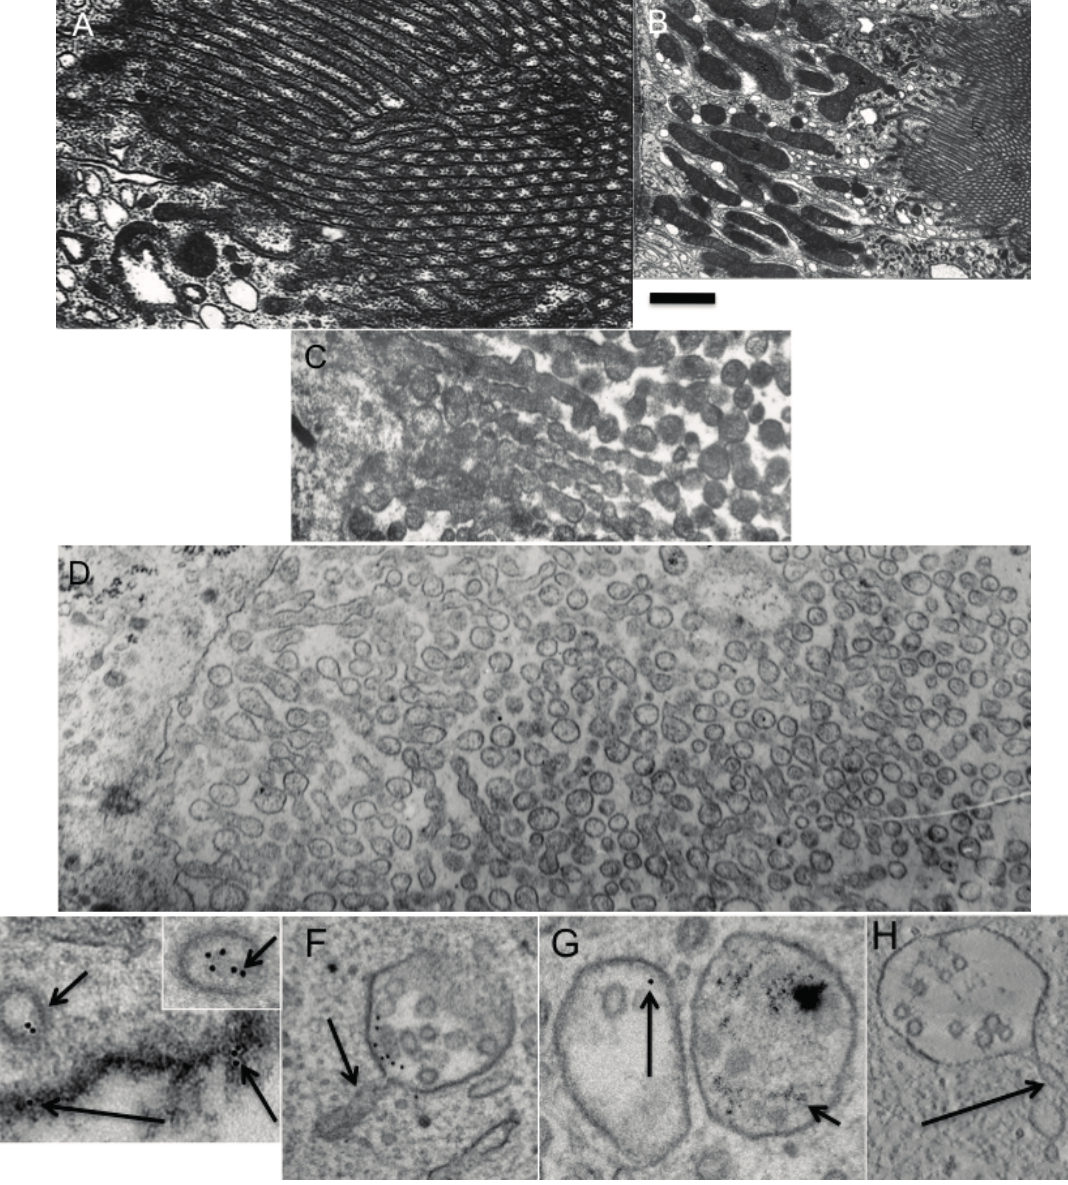
Figure 7. Breakdown of epithelial microvilli of kidney proximal tubule into membrane spheres. ( A ). Normal brush border consists of cylindrical protrusion of the apical plasma membrane; ( B ) General view of the brush border; ( C ) Formation of varicosite cylinders from cylindrical microvilli; ( D ) Transformation of varicose cylinders into small membrane spheres; ( E ) Formation of the endocytic clathrin-coated vesicles (short arrows) with a diameter of 90 and 128 nm (insertion on the right). The large vesicle contains more gold particles but no intraluminal vesicles. Long arrow shows gold particcles embedded into oxidized 3,3'–diaminobenzidine (dark precipitate); ( F – H ) Formation of multivesicular bodies containing tubular protrusions with a diameter of 40 nm (arrows in F , H ). ( G ) Two multivesicular bodies: one filled with 5-nm gold particles (on the right, short arrow) and another filled with 10-nm gold particles (on the left, long arrow). Bars. 230 nm ( A – D ); 100 nm ( E – H